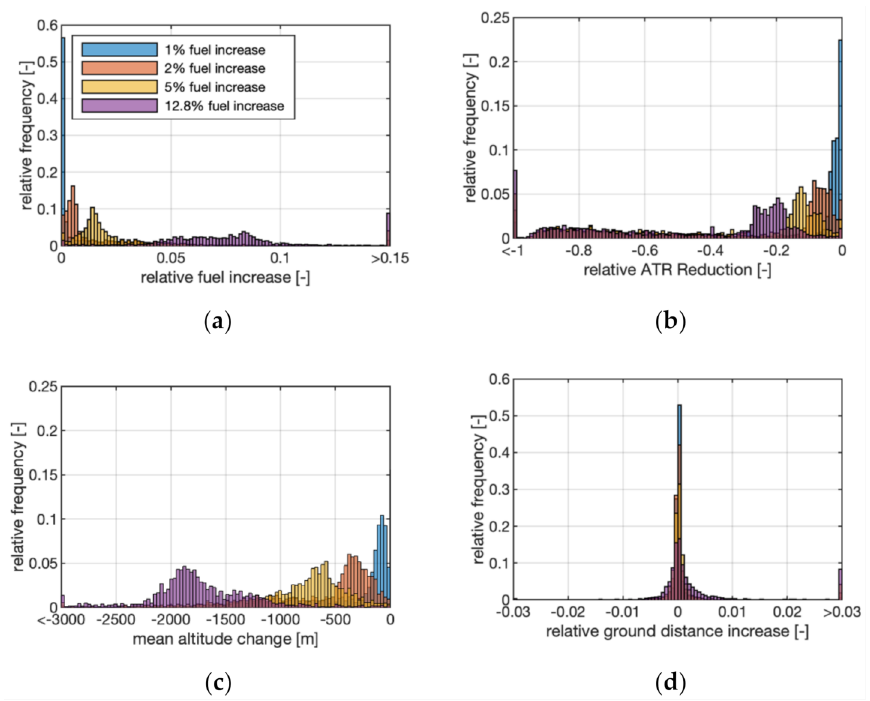
Figure 9. Frequency distributions of the relative fuel increase ( a ), the relative ATR reduction ( b ), the mean altitude change ( c ), and the relative ground distance increase ( d ) compared to the minimum fuel trajectory based on the top 2000 routes for 1% (blue), 2% (orange), 5% (yellow), and 12.8% (purple) overall fuel